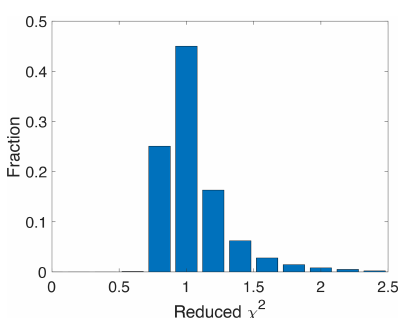
Figure A7. Histogram of reduced χ 2 from all converged retrievals in this